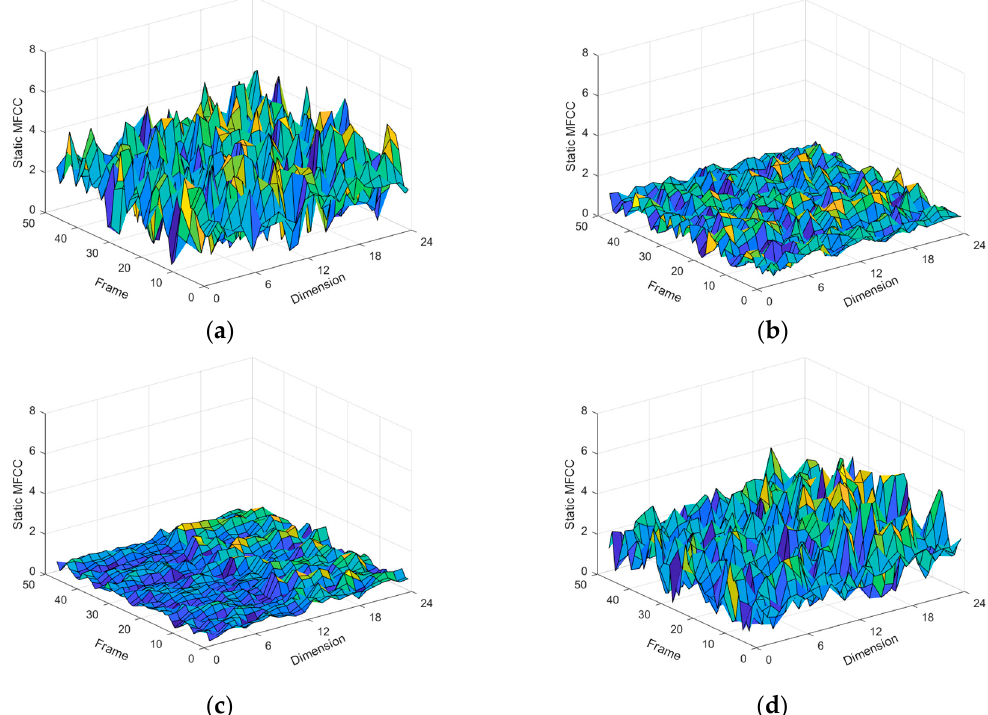
Figure 8. Delta MFCC features calculated from static MFCC features under different kind of insulation